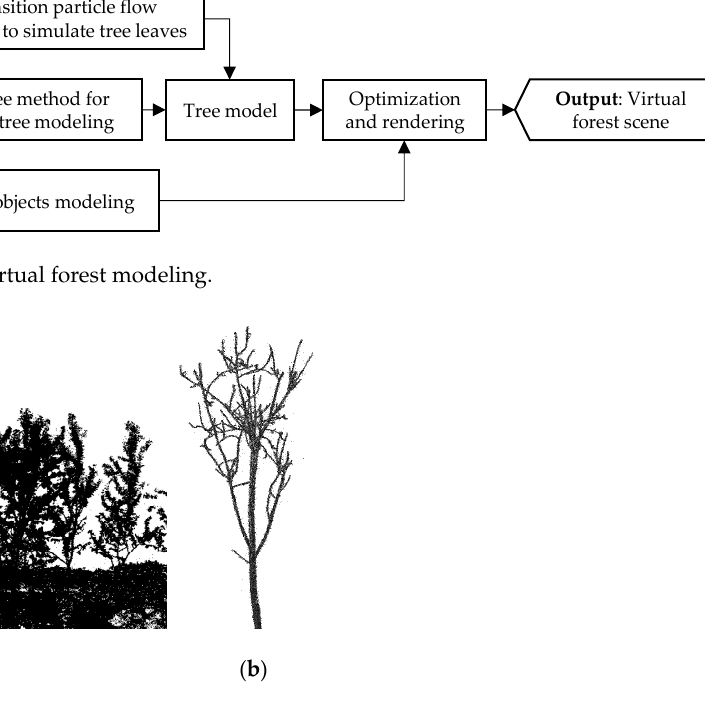
Figure 3. Forest site point cloud data. ( a ) Local point cloud data of poplar plantation. ( b ) Point cloud data of tree branches and trunks.